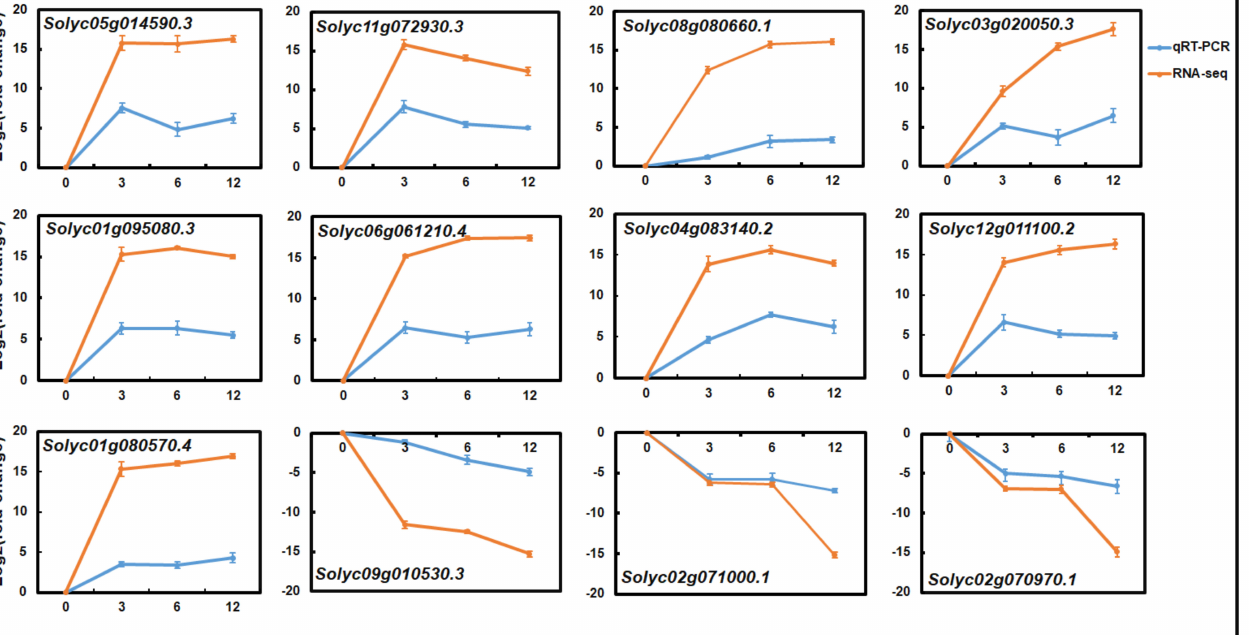
Figure 4. The changes in the expression levels of 12 genes regulated by SCR96 over the time course were confirmed with qRT-PCR. Expression level values of each gene were normalized to the expression level values of the housekeeping actin gene and transformed using log2 as for the RNA-Seq fragments per kilobase of transcript per million fragments mapped (FPKM) values. The assays were repeated three times and showed similar expression patterns. Bars indicate standard